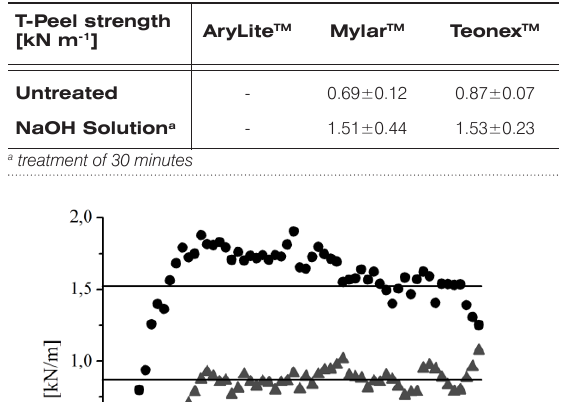
Table 6. T-Peel strength of unmodified and treated polyester